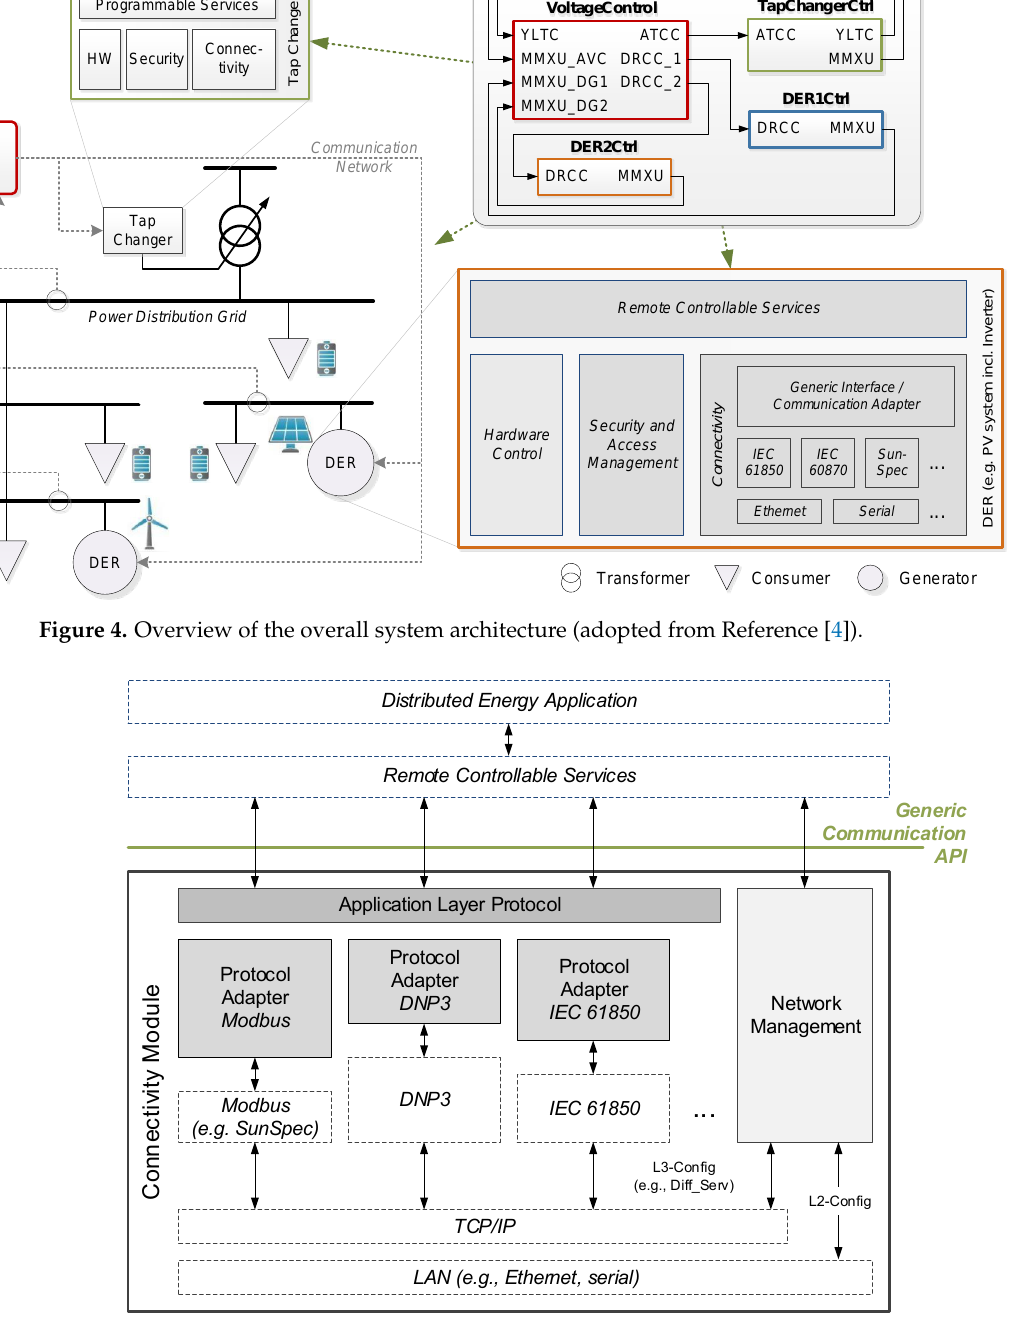
Figure 5. Elements of the connectivity